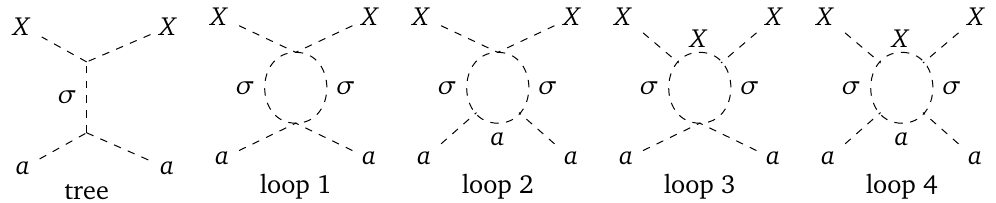
Figure 5: Tree and loop diagrams contributing to the elastic scattering of scalar dark matter X with angular mode a